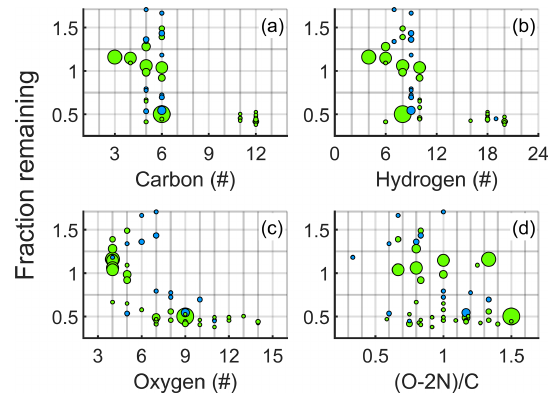
Figure 7. Fraction remaining (FR) after seed addition as a function of elemental composition. This figure is similar to Fig. 6, except that here the FR of products is plotted against the (a) carbon, (b) hydro- gen and (c) oxygen contents of the compounds, as well as against (d) the effective O:C ratio ( O − 2N )/